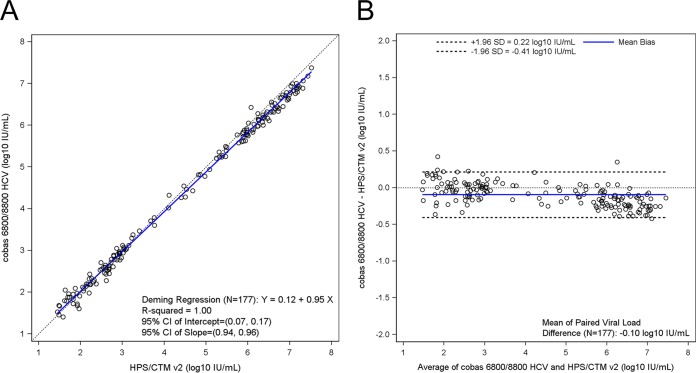
(a) Deming regression plot for cobas 6800/8800 HCV versus HPS/CTM v2 (n = 177). (b) Bland-Altman plot for cobas 6800/8800 HCV versus HPS/CTM v2 (n = 177). CI, confidence interval; HPS/CTM v2, cobas TaqMan HCV Test, version 2 for use with the High Pure system.